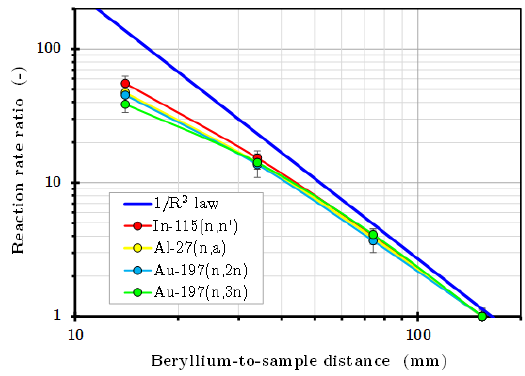
Figure 7. Reaction rates ratios in dependence on target-to- sample